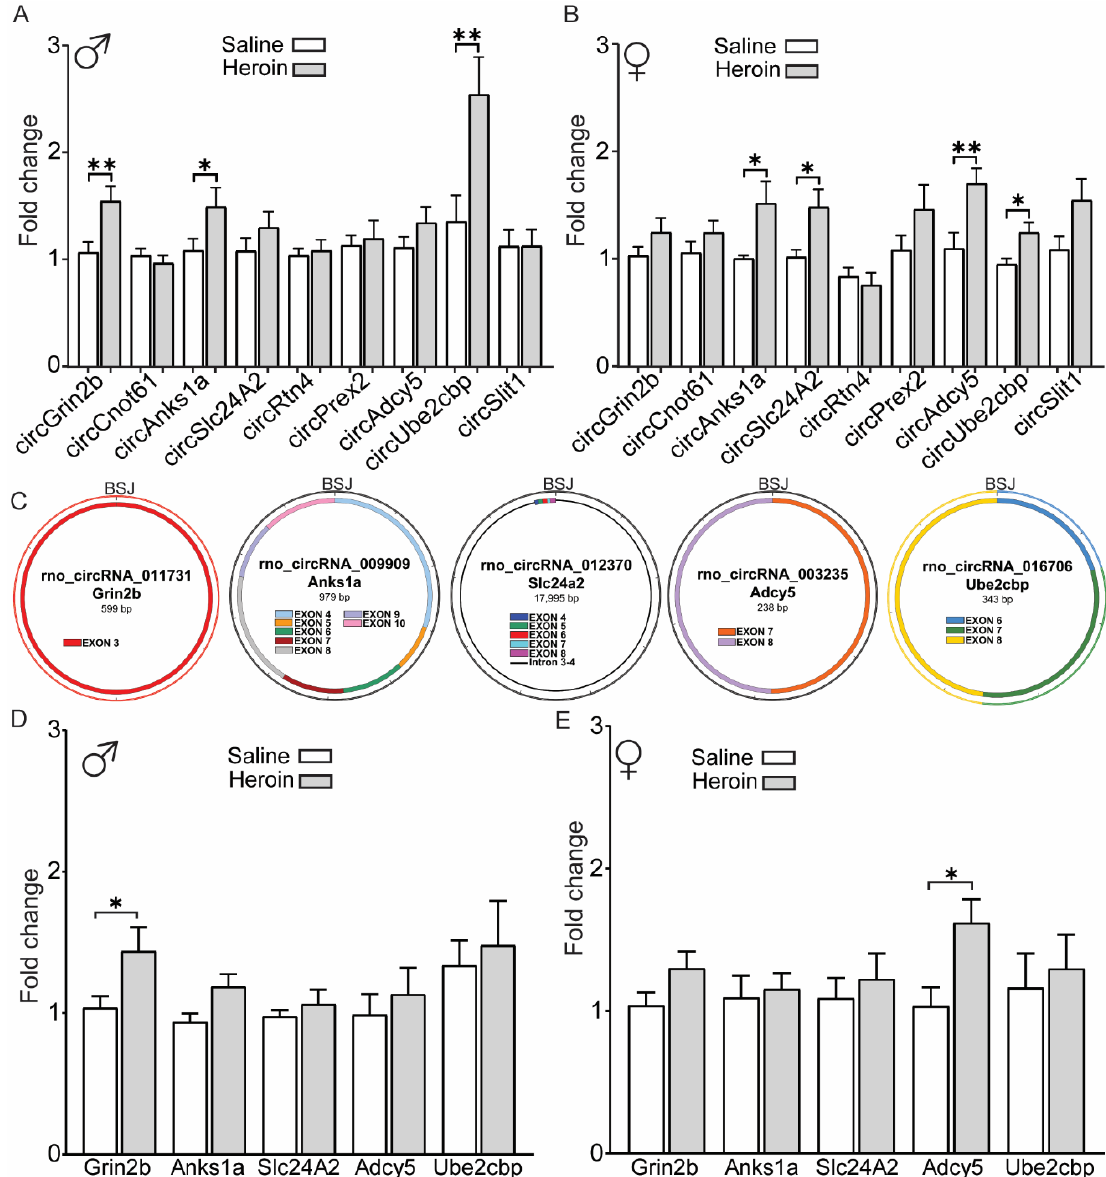
Figure 4. Regulation of heroin-associated circRNAs and their linear counterparts in the OFC. ( A , B ) qPCR validation of putative heroin-associated circRNAs in male ( A ) and female ( B ) animals after heroin or saline self-administration. ( C ) Maps of the predicted exons and introns that constitute each validated heroin-associated circRNA. BSJ—backsplice junction. ( D , E ) qPCR measurement of the linear mRNAs that give rise to each heroin-associated circRNA in male ( D ) and female ( E ) animals after heroin or saline self-administration. Error +/- SEM. * p < 0.05; ** p < 0.01. 2.3. Regulation of Heroin-Associated circRNAs May Be Independent of Host Gene Regulation Individual circRNAs may be co-regulated with their linear counterparts or independently regulated [21], suggesting the existence of independent cellular functions. Therefore, upregulation of heroin-associated circRNAs may simply be due to more linear mRNA production. To address this, we next measured the expression of the linear mRNA counterparts of validated circRNAs to gain more insights into the specific regulation of